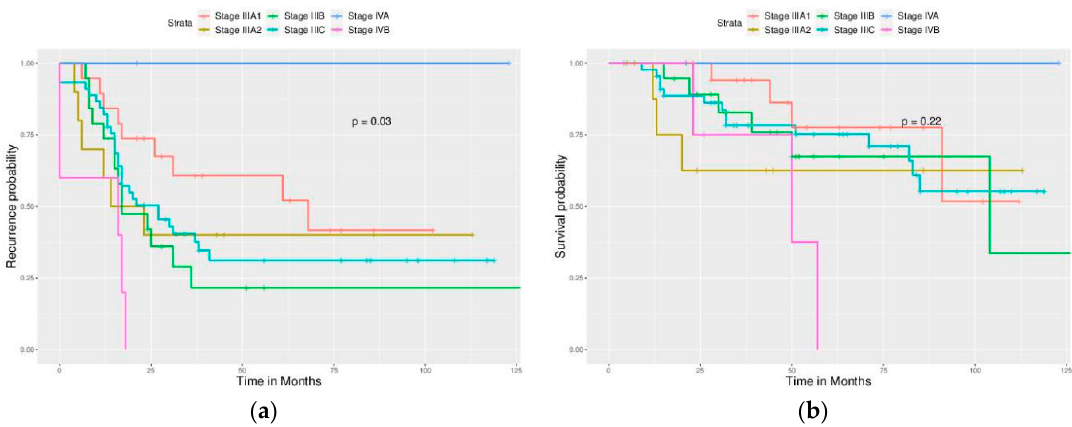
Figure 6. Survival curves based on the FIGO stage (Optimally debulked group). ( a ) PFS, p = 0.03. ( b ) OS, p = 0.22.